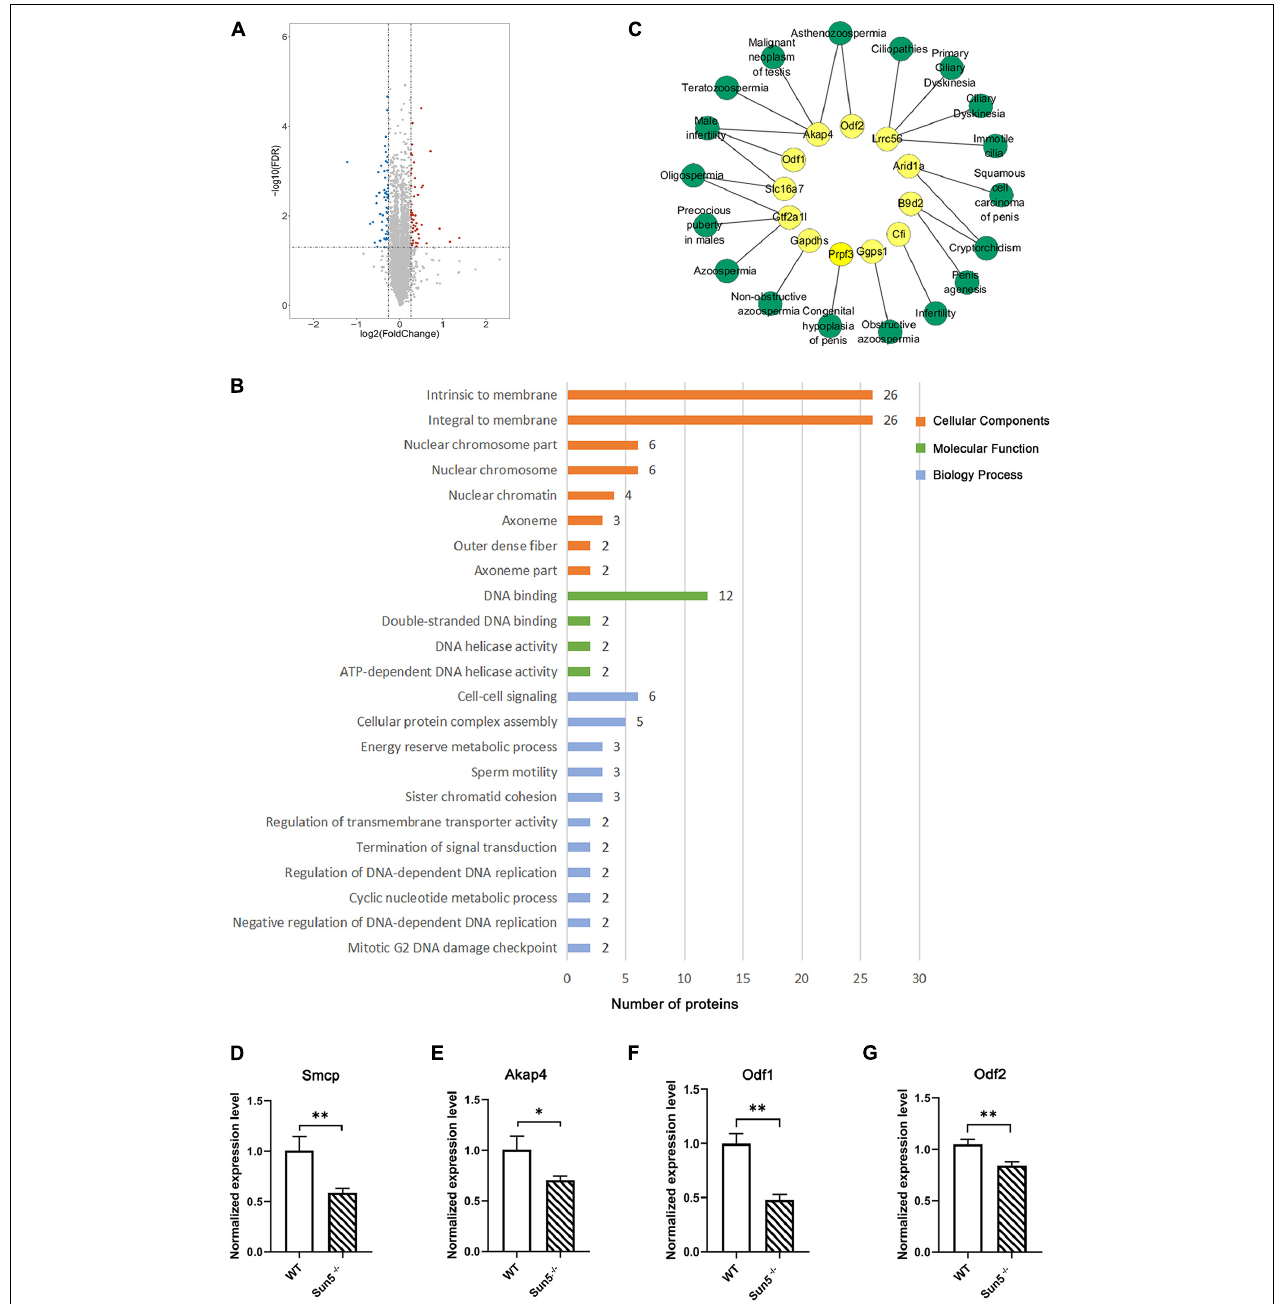
FIGURE 7 | Identification and functional annotation of differentially expressed proteins (DEPs) in testes of WT and Sun5 − / − mice. (A) Volcano plot of fold change and FDR for 6436 quantified proteins. (B) GO enrichment analysis of cellular components, molecular functions and biological processes of DEPs in Sun5 − / − mice. (C) The network of downregulated proteins and reproductive diseases in humans was annotated by the DisGeNET database. Yellow represents DEPs, and green represents reproductive diseases. (D–G) Validation of DEPs related to spermatogenesis at the mRNA level. Data are presented as the mean ± SEM, n = 3. ∗ P < 0.05, ∗∗ P <